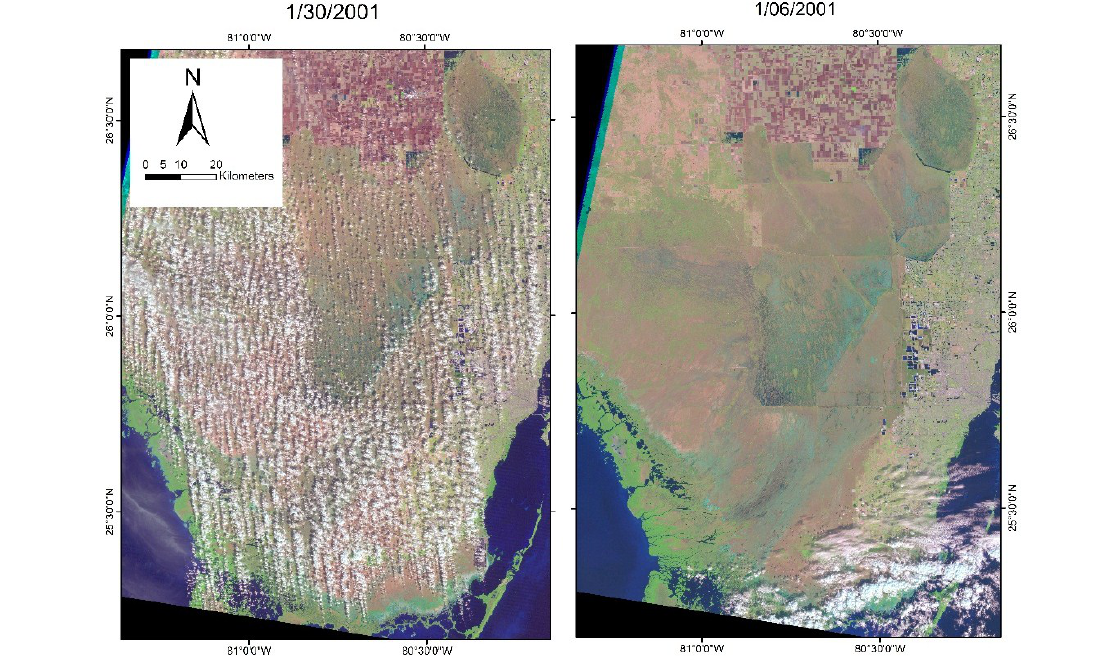
Figure 7. False color composite (Band 5: Red; Band 4: Green, and Band 3: Blue) for a Landsat scene with cloud contamination that is grossly underestimated in the Archive database but which was used in the analysis ( Left ), and a Landsat scene with nearly no cloud cover over the wetlands of interest ( Right ) that was excluded from analysis given its Archive attribute of 28% cloud